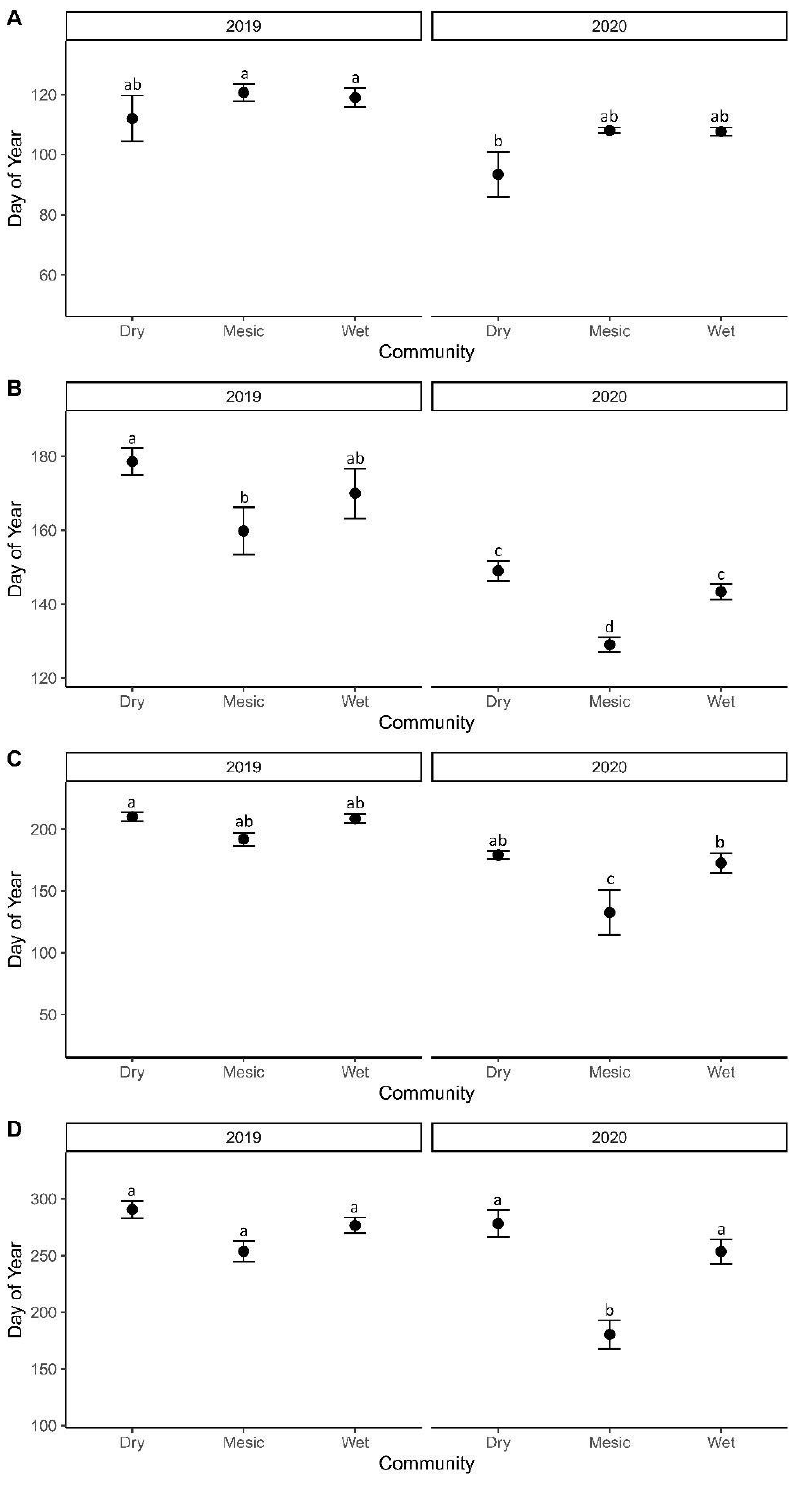
Figure 5. Mean ( ± SE) phenophase values across vegetation communities and years. Phenophase stages are ( A ) upturn date (UD), ( B ) stabilization date (SD), ( C ) downturn date (DD), and ( D ) recession date (RD). Different letters indicate significant differences.